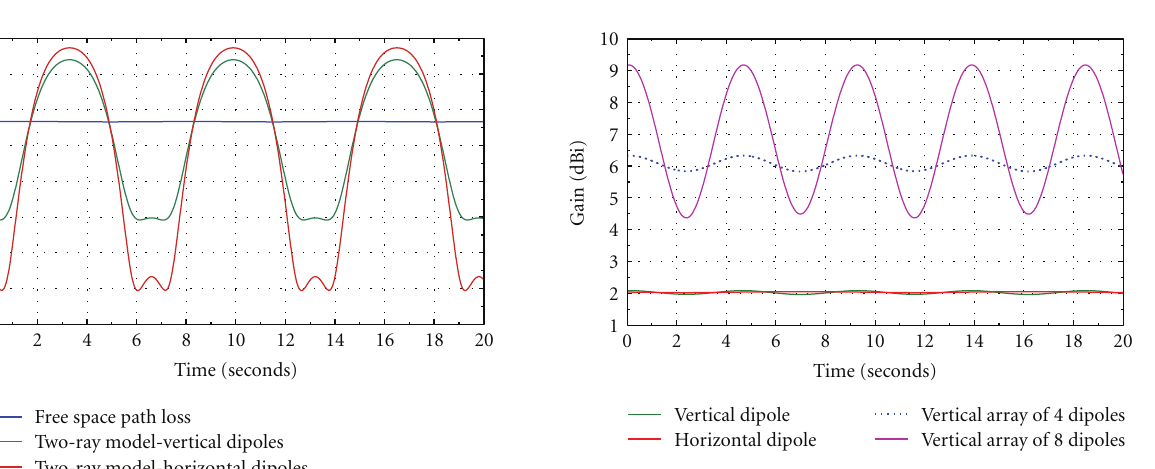
Figure 9: Gains at transmission on the direct path with dipole and arrays of